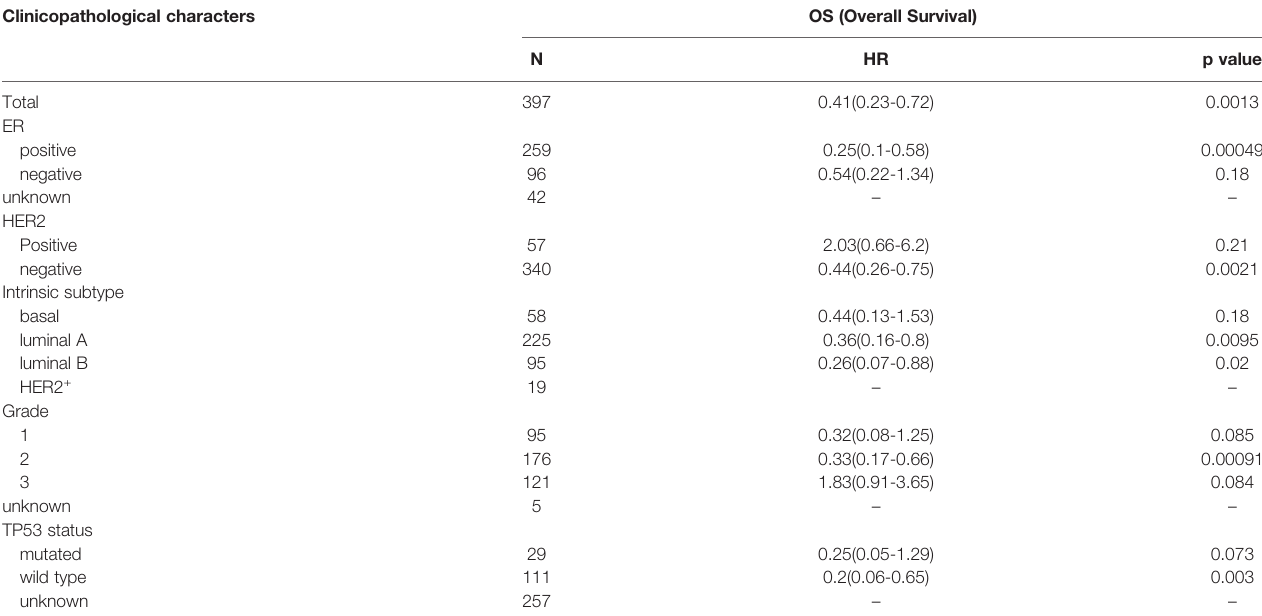
TABLE 3 | Correlation between TP63 expression and different clinical pathological factors by Kaplan-Meier plotter. Clinicopathological